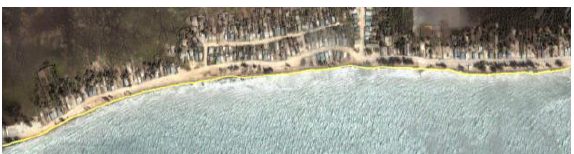
Figure 6. Result of the vector generated over an cumulative coastal sector.